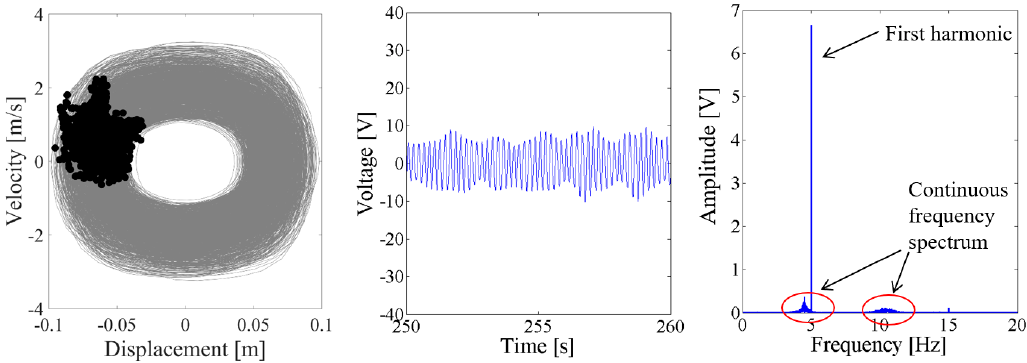
Figure 20. Dynamic responses of the coupled harvester-1 for the excitation level of 1.5 g.